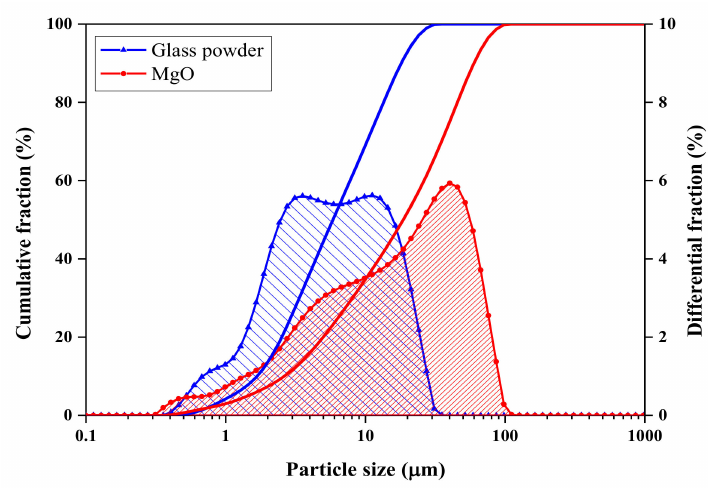
Figure 1. Particle size distribution of dead-burnt MgO and glass powder. Table 1. Chemical composition of dead-burnt MgO and glass powder in wt.%. Chemical